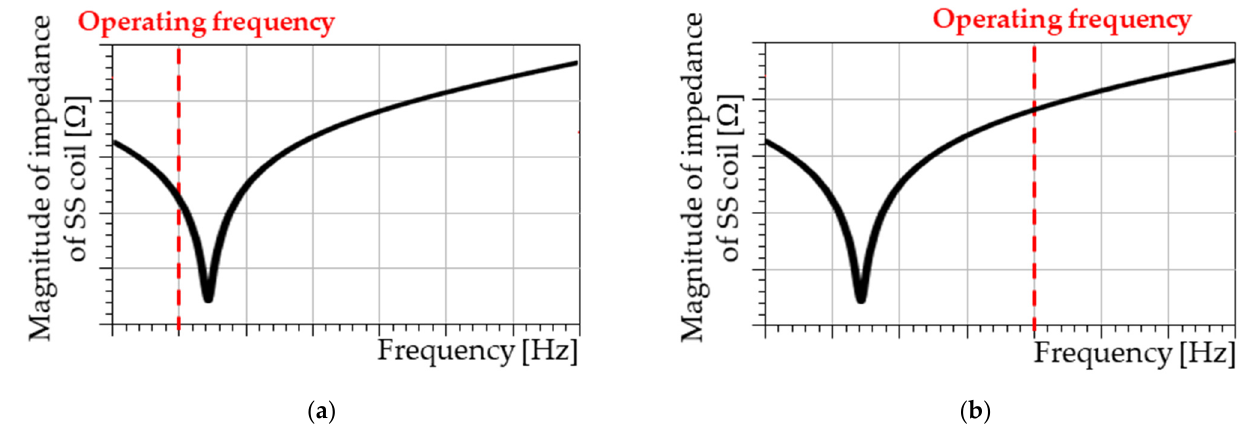
Figure 5. Current phase of the SS coil according to the relationship between the resonant frequency of the SS coil and the operating frequency of the system. ( a ) Capacitive region (operating frequency < resonance frequency of the SS coil). ( b ) Inductive region (operating frequency > resonance frequency of the SS coil).